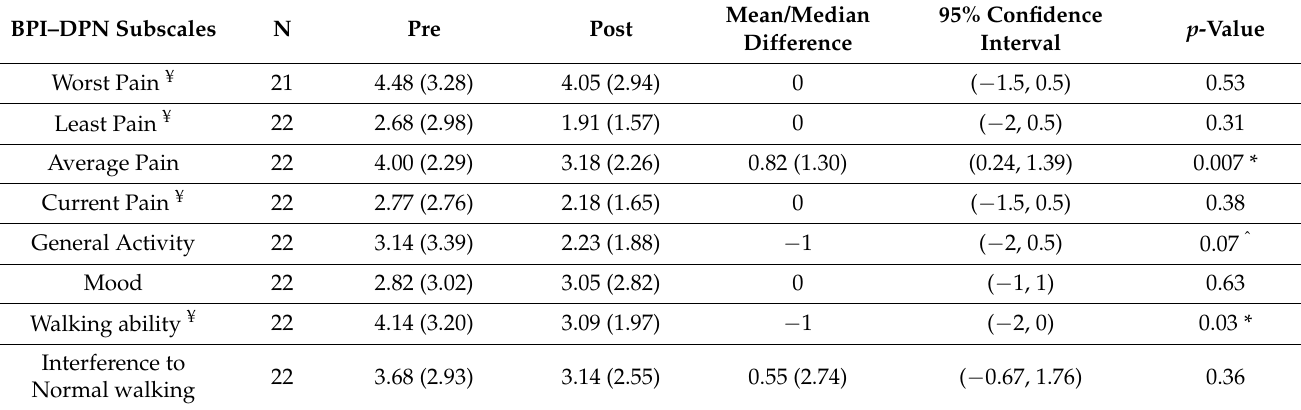
Table 3. Item scores on BPI–DPN pre- and post-intervention in individuals with